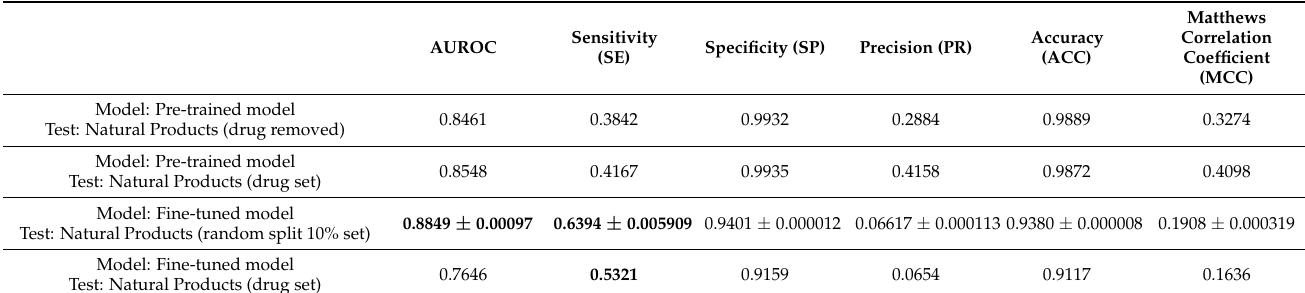
Table 2. Validation scores of the pre-trained model and fine-tuned model. The values that were promoted are bolded in the table.